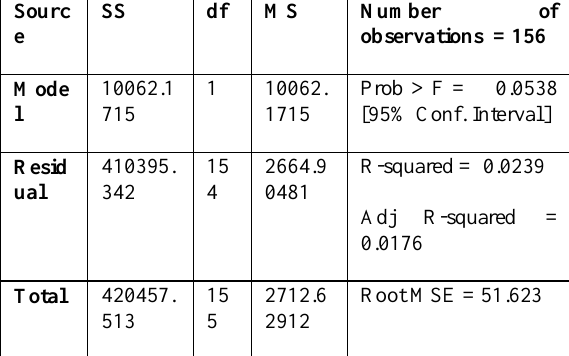
Figure 4: Voronoi polygon on coverage